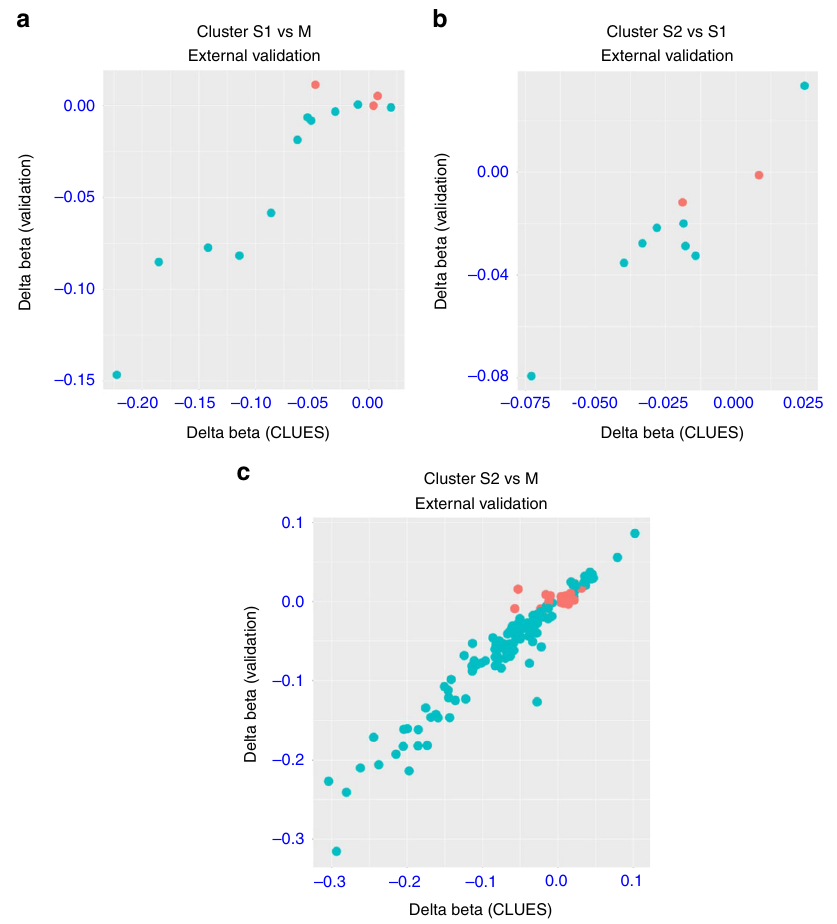
Fig. 4 Validation of differentially methylated CpGs between clusters. Differentially methylated CpGs between clusters were validated in an external dataset (19) a cluster S1 vs M. b cluster S2 vs S1 c cluster S2 vs M. Difference in CpG beta values for differentially methylated sites in CLUES data on x axis and corresponding delta beta value for CpG in validation data on y axis. Green color indicates signi fi cant association with cluster in validation dataset (FDR <